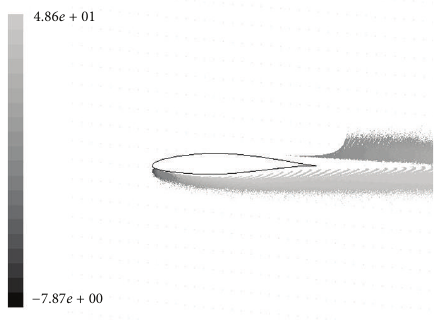
Figure 18: Raindrop traces at AOA = 20 degree.